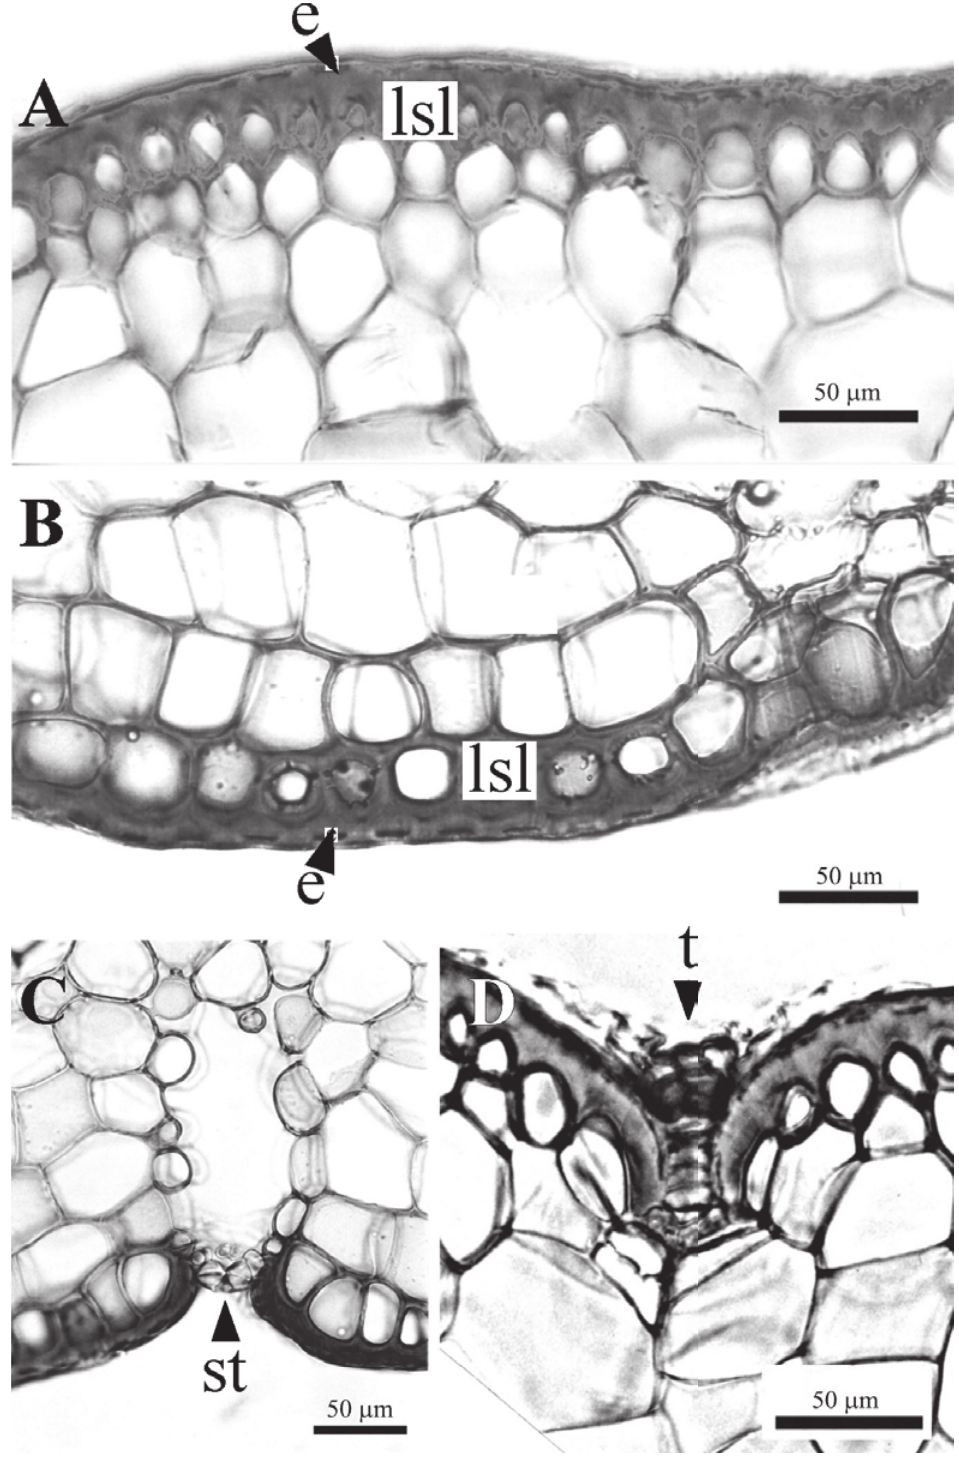
Figure 4 - Epidermis of Neoregelia cruenta in transversal view. (A) adaxial surface, (B) abaxial surface, (C) detail of stoma and stomatic chamber, (D) detail of adaxial trichome. e - epidermis, lsl – lignifi ed subepidermal layer, st - stoma, t -